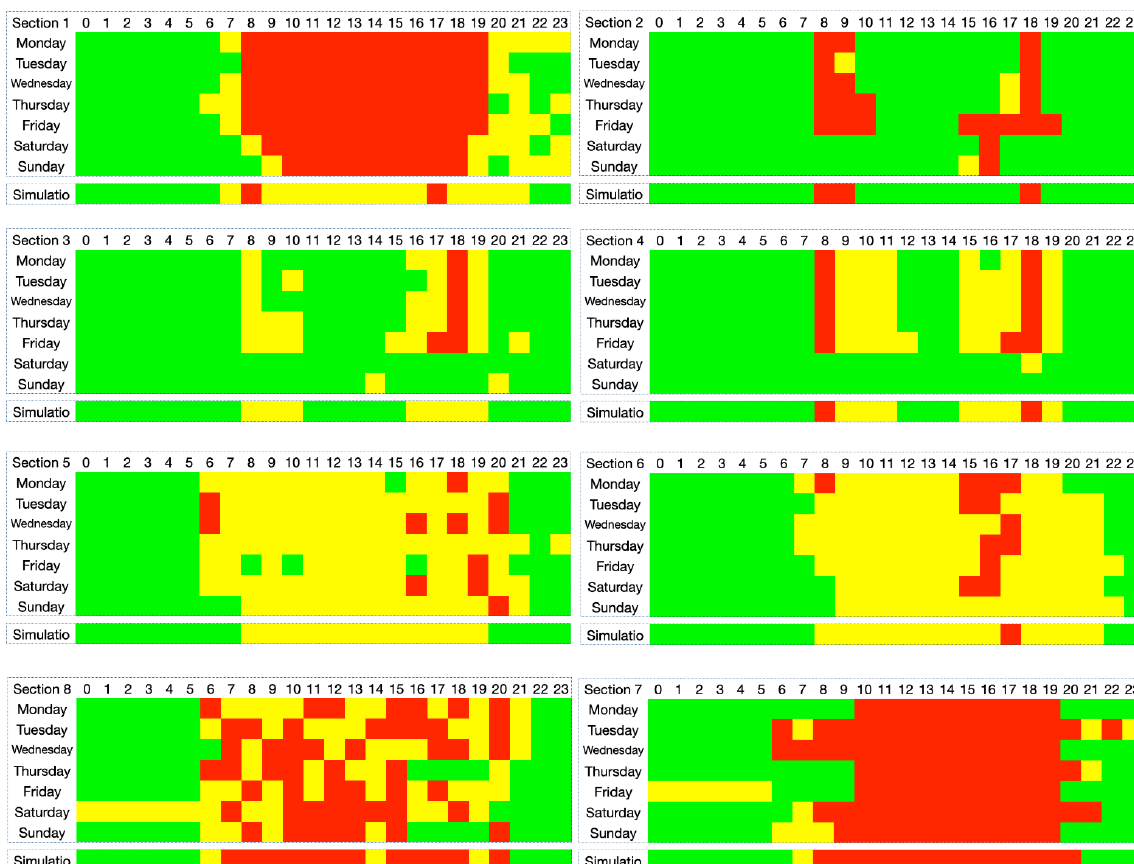
Figure 4. Eight selected road sections’ location and features.